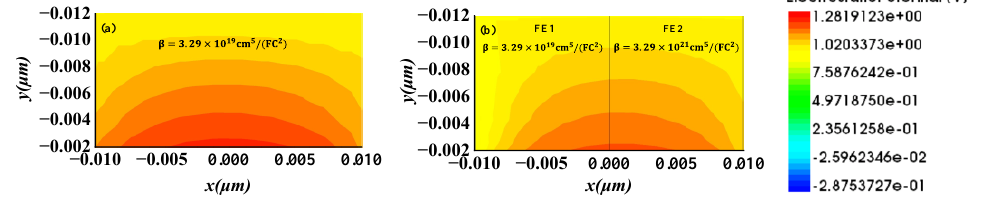
Figure 3. Potential distribution of the ferroelectric region, ( a ) conventional ferroelectric region, ( b ) dual ferroelectric region with variable β .